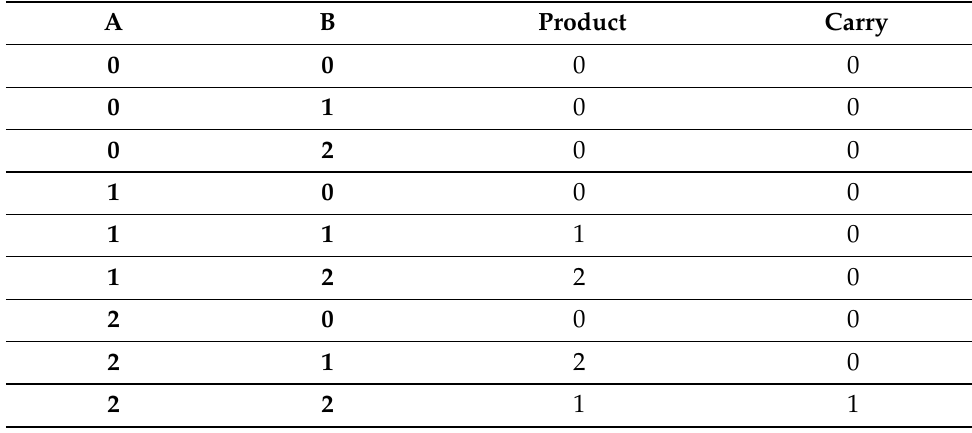
Table 3. Single-trit Ternary Multiplier Truth